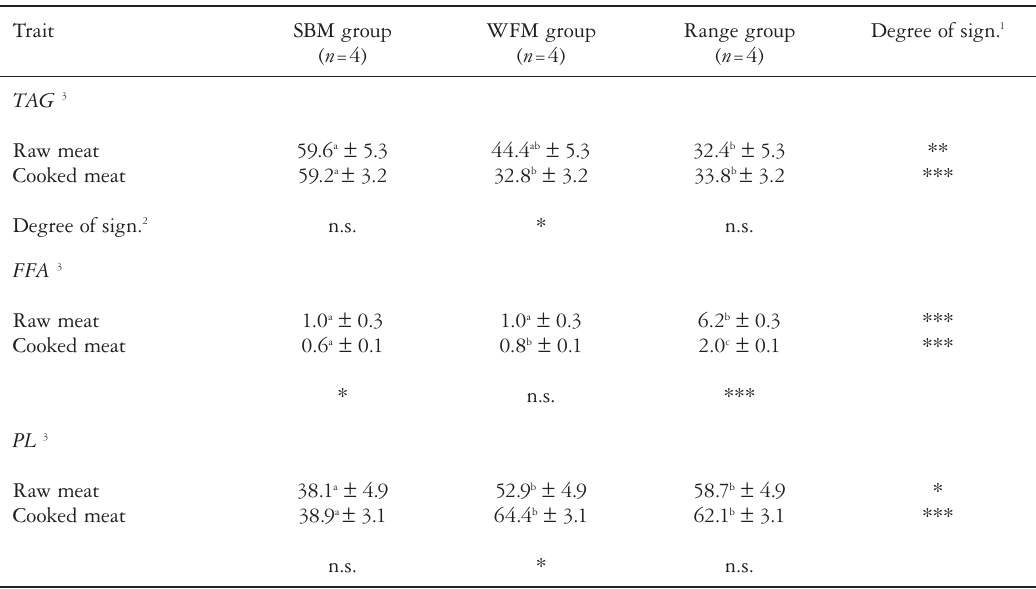
Table 8. Lipid class composition ( TAG=triglycerides, FFA=free fatty acids, PL=phospholipids ) of raw and cooked M. longissimus (LD) in reindeer from three different feeding treatments; SBM (feed mixture based on soybean meal protein), WFM (feed mixture based on fish meal protein) and grazing free ranging animals included in the study (least-squares means and standard